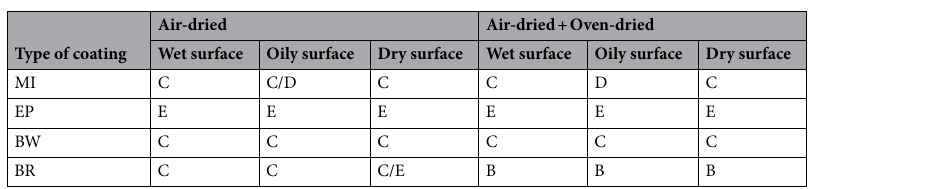
Table 5. Adhesion test summary of types of